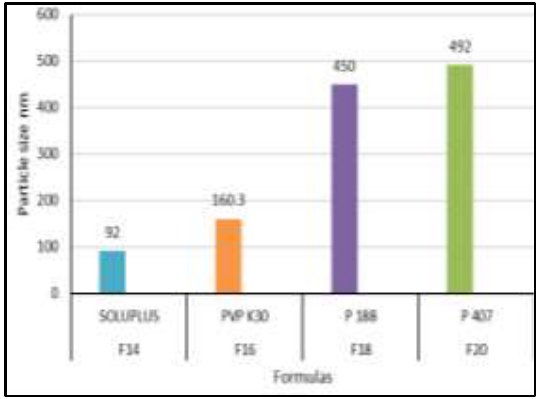
Figure 5. Effect of polymer type when using ethanol on particle size for the formulations F14, F16, F18, and F20